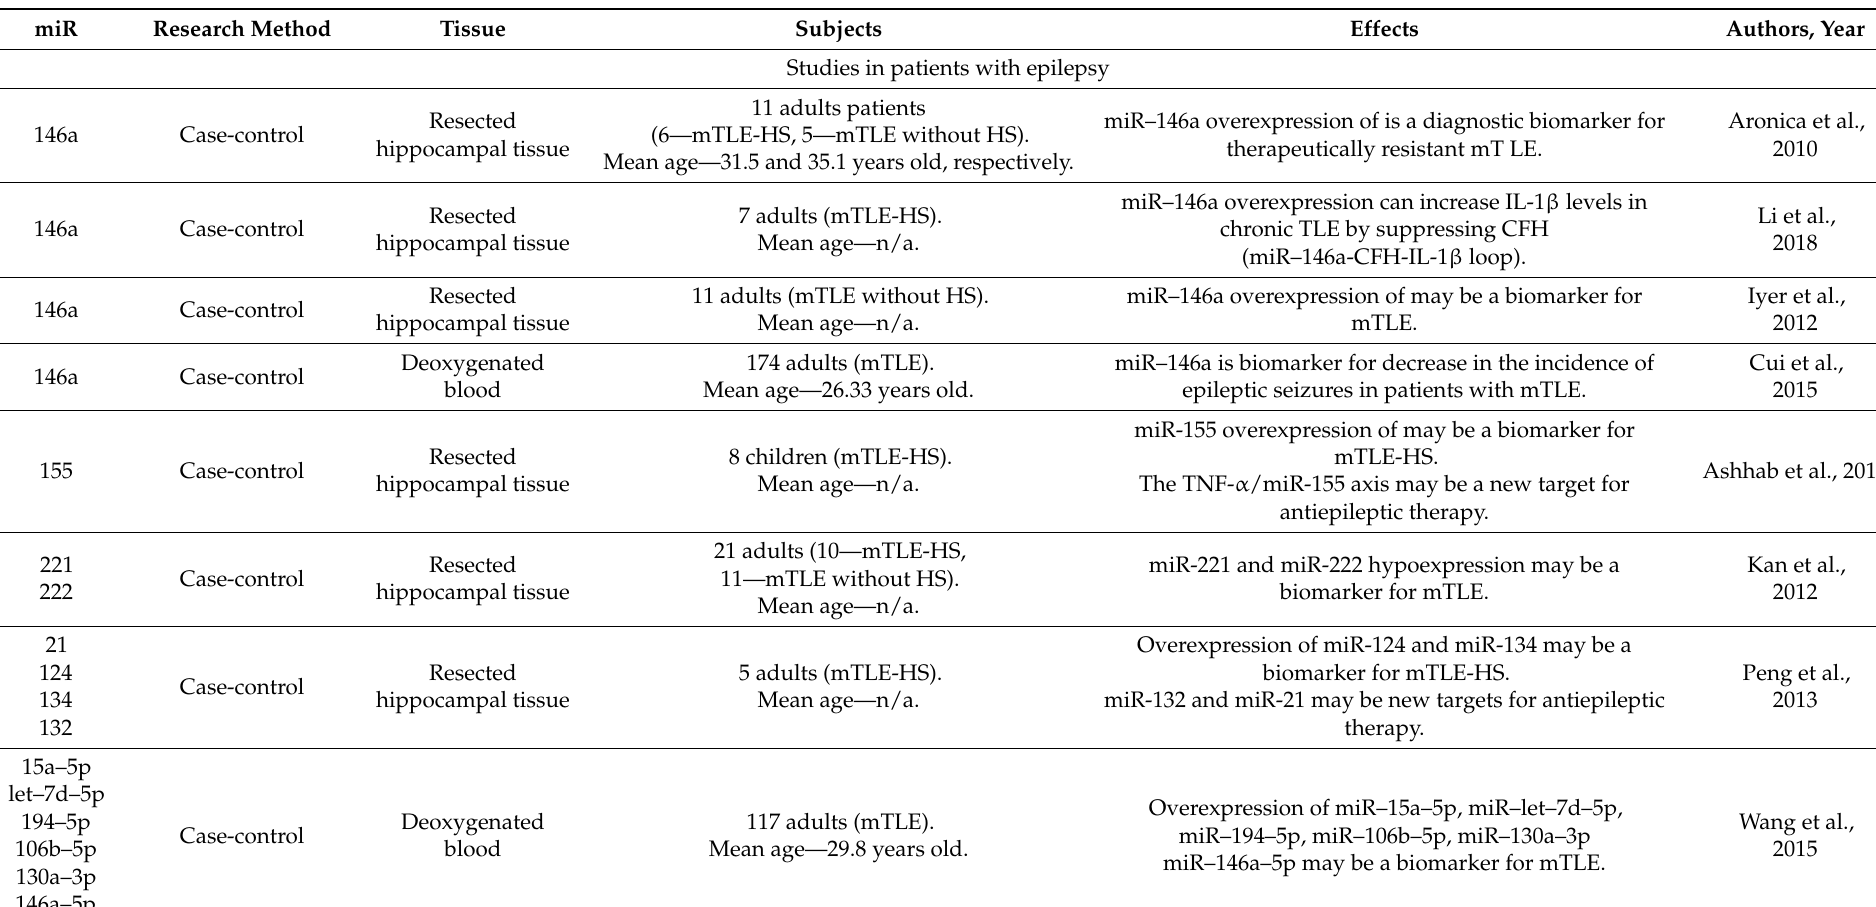
Table 2. MicroRNAs are potential biomarkers for the development of therapeutic resistance to antiepileptic drugs in patients with mesial temporal lobe